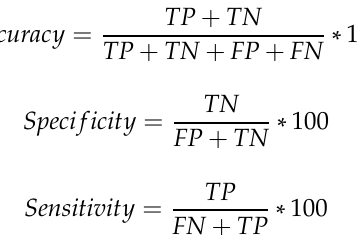
Table 7. Features used in [25]. 404